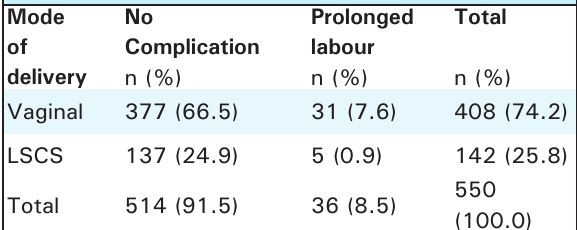
Table 3. Association between mode of delivery